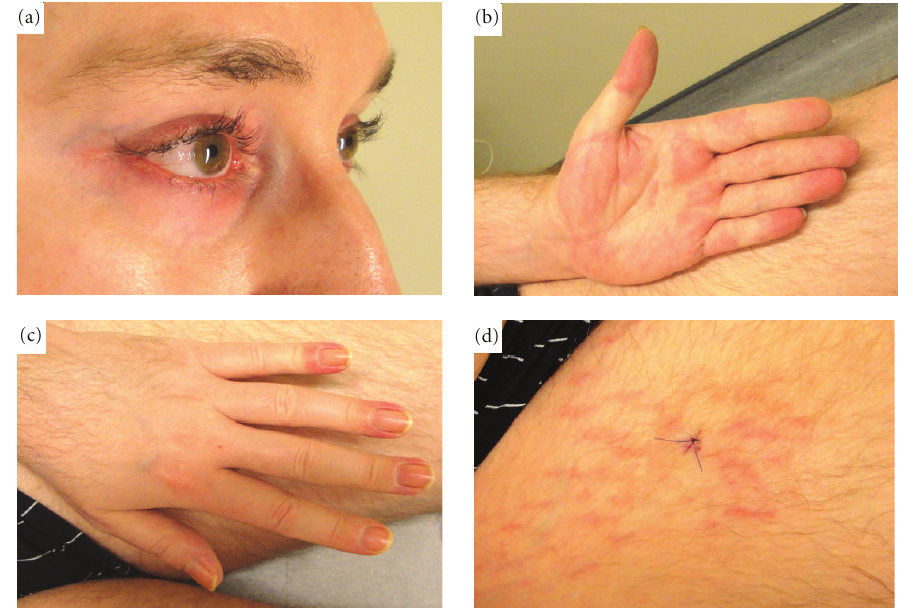
Figure 1: Cutaneous features of DM. (a) Heliotrope erythema, (b) palmar erythema, (c) periungual erythema, and (d) flagellate